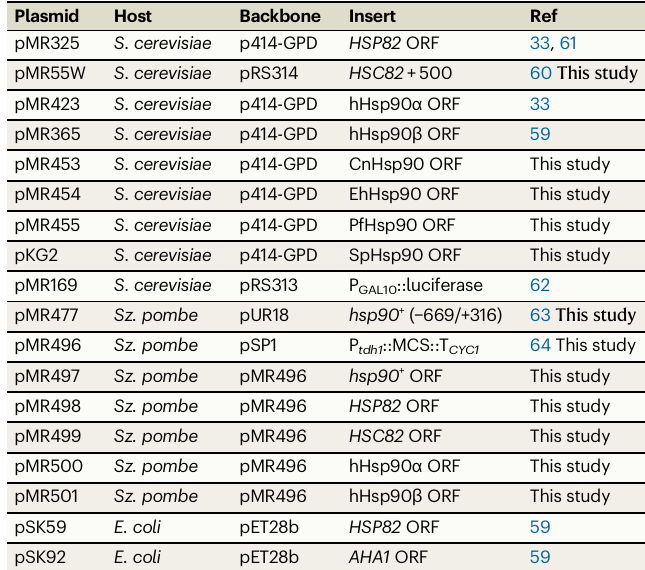
Table 2 | Plasmids used in this